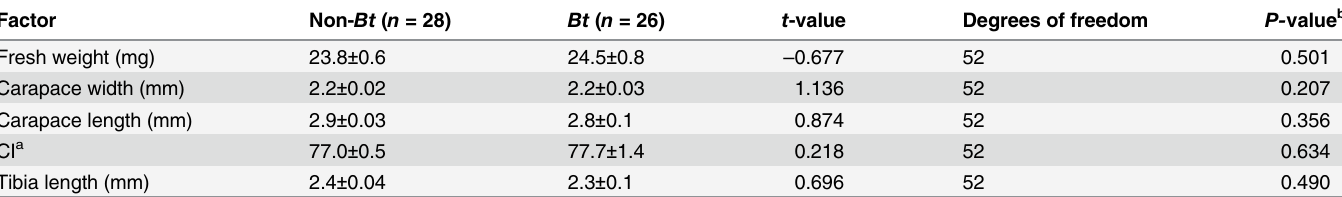
Table 3. Comparisons of body sizes for P . astrigera exposed to non- Bt cabbage-fed versus Bt cabbage-fed D . melanogaster .